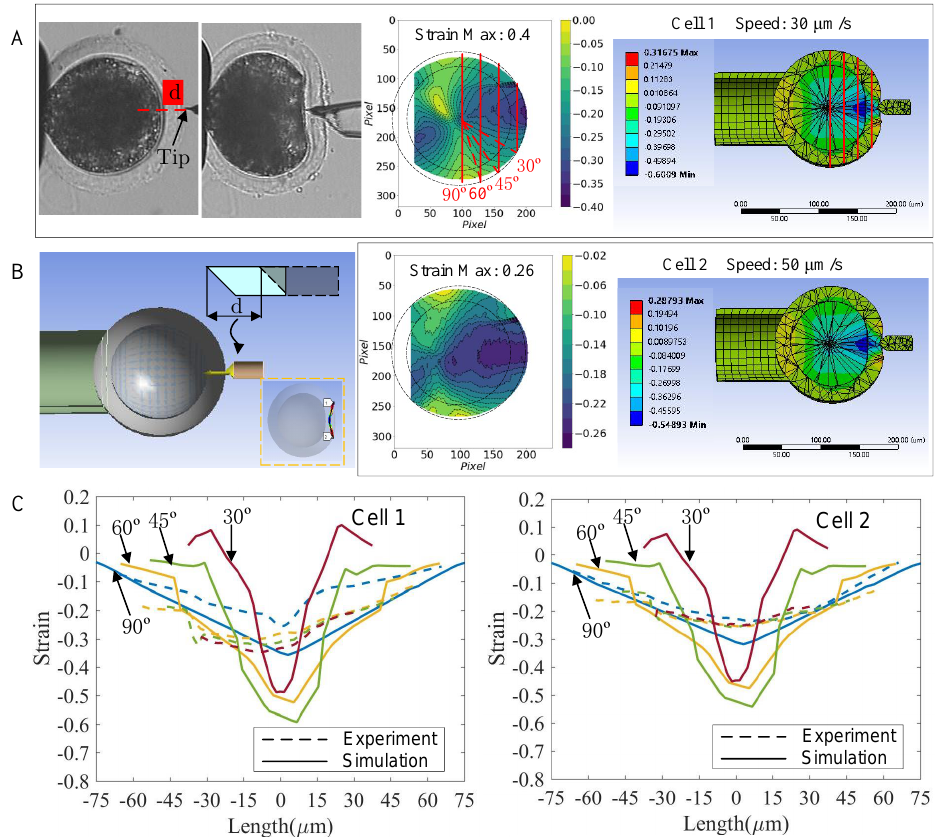
Figure 9. Validation of the model in the microinjection experiment. ( A ) The intracellular strain that was produced at the moment when the microinjector tip just penetrated the oocyte membrane. The microinjector moved at a speed of 30 µ m/s and had the displacement of d µ m from the start of the movement to the moment when it just penetrated the membrane (left). The microscopic images of the two frames were analyzed to obtain the experiment result (middle). The tip displacement d was given as the input for the model, from which the intracellular strain was generated and shown in the right image. ( B ) Moving the microinjector tip at a speed of 50 µ m/s. ( C ) The comparison between the experimental and simulation results. We extracted the strain values from the four vertical lines across the half-right cell region. For the 30 ◦ vertical line, the line linking the cell center and the end of the 30 ◦ vertical line formed an angle of 30 ◦ with the horizontal line that passed the cell center and the tip. The simulation result showed a similar strain distribution as the experimental result, but with a moderately larger maximum